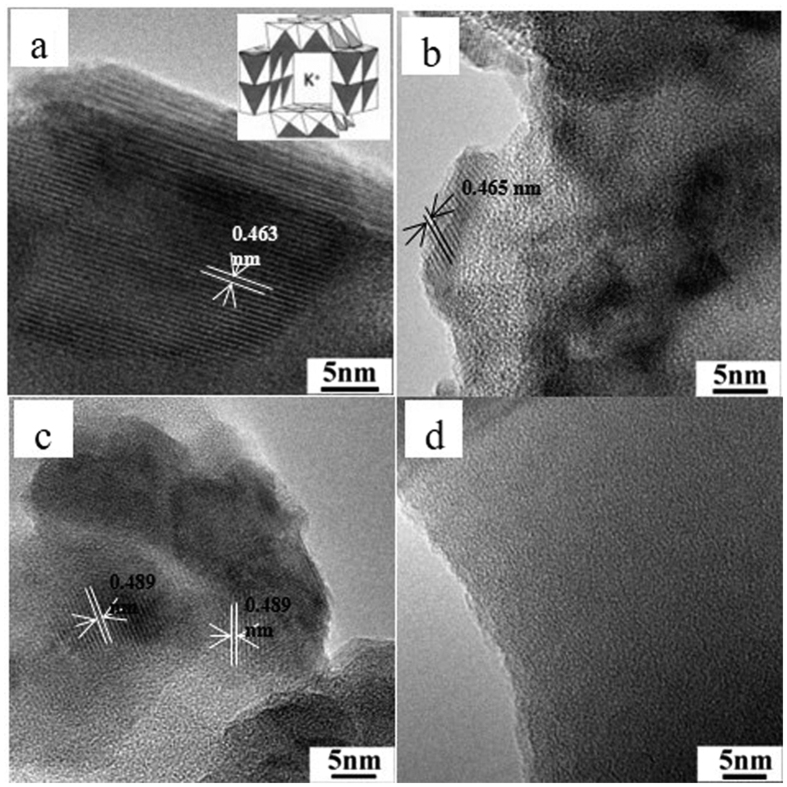
HRTEM images of K-OMS-2/SiO2-50 (a), K-OMS-2/Silica gel-50 (b), MnOx/SiO2-50 (c) and KNO3/SiO2-50 (d).